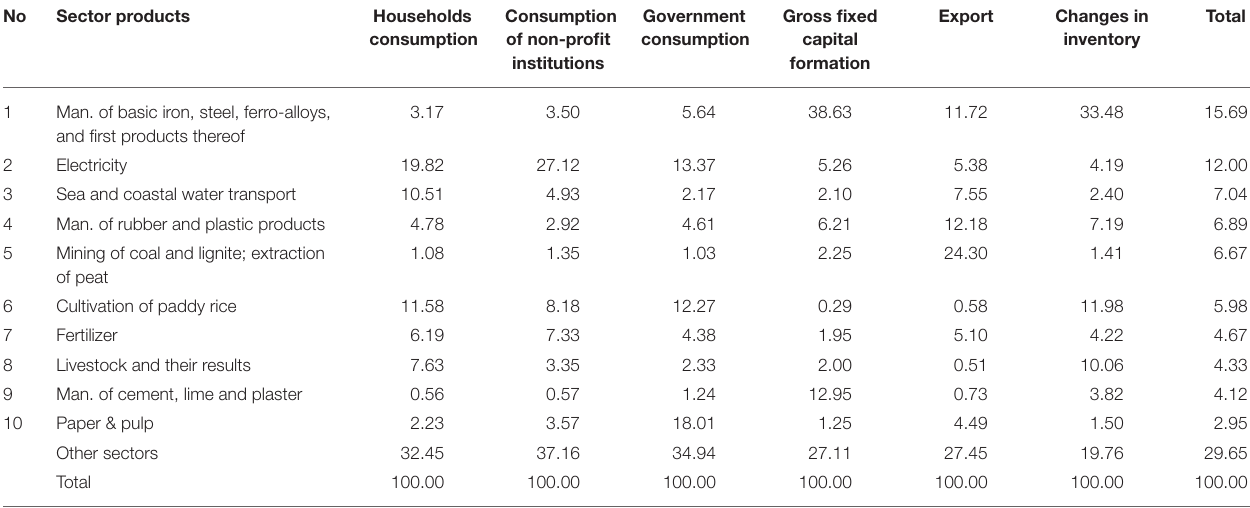
TABLE 4 | Top 10 of total environmental cost from emissions by sector in Indonesia in 2010 (percent). No Sector products